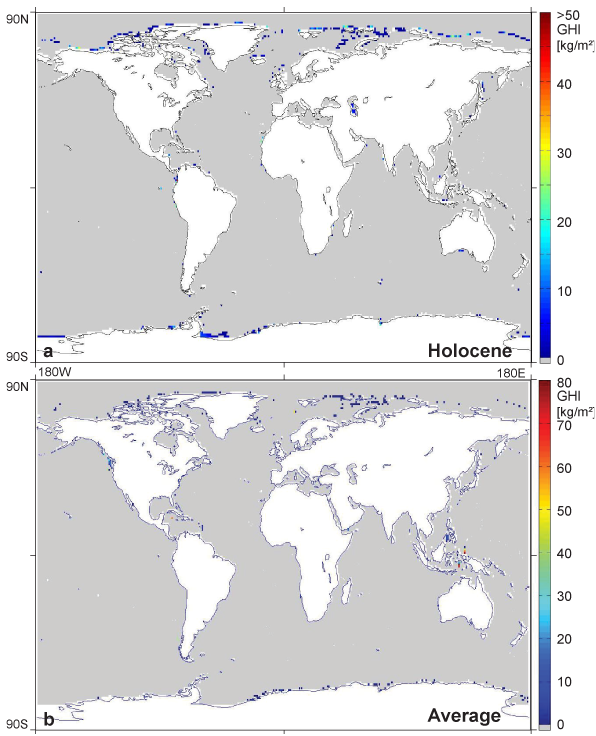
Fig. 5. (a) Distribution map of the gas hydrates formed by methane generated through degradation of organic matter within the GHSZ (GHI full comp , Eq. 2), considering complete sediment compaction, under Holocene conditions (Scenario #1) for POC and SR and Hamza’s data set to calculate the thickness of the gas hydrate stabil- ity zone ( L GHSZ ); (b) distribution map of the gas hydrate concen- tration considering complete sediment compaction (GHI full comp , Eq. 2), under sedimentation rates averaged over geological times (Approach #2 for POC and SR) and Hamza heat flow data set to calculate the L GHSZ